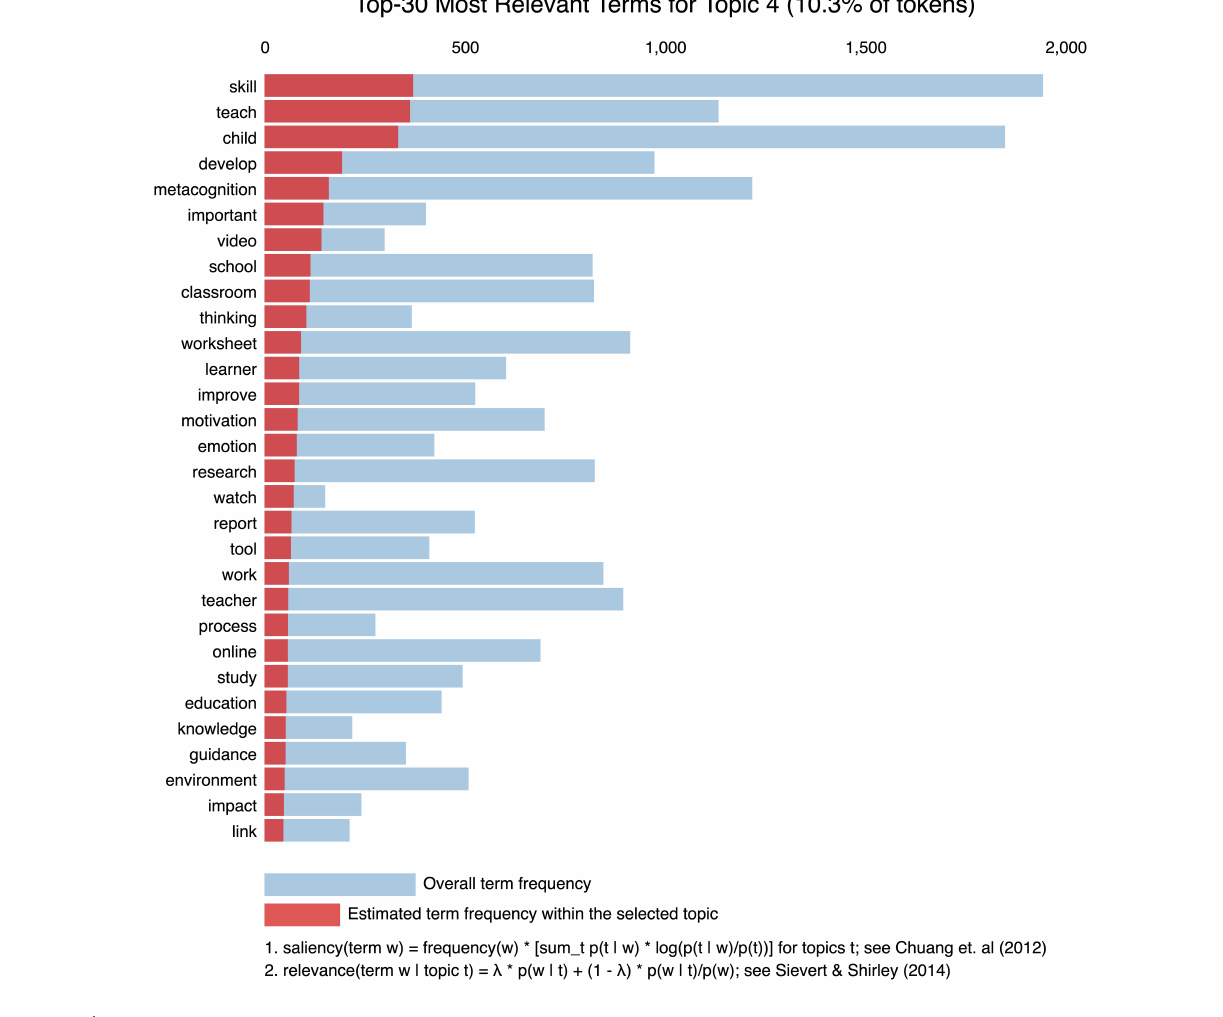
FIGURE 7 | Most relevant terms for topic 4 (10.3% of the tokens). TABLE 5 | Topic classification, keywords, and size based (common appearing words excluded).